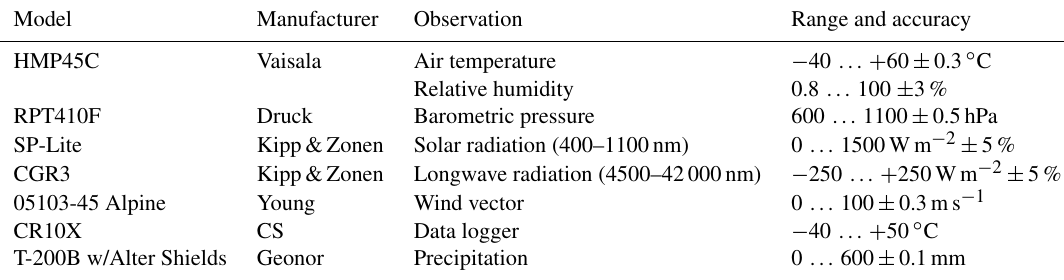
Table 2. Instruments and specifications used on the permanent weather station at the Refugio Poqueira monitoring point. Model